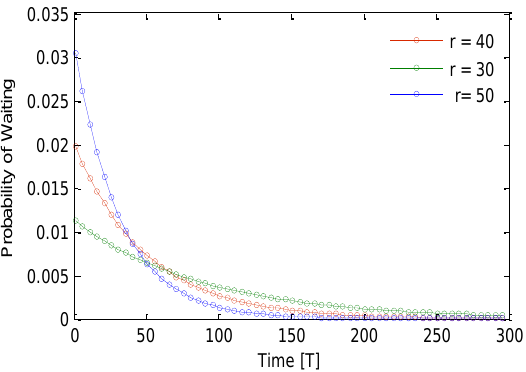
Figure 8. Probability of waiting for a finite time for the HelloReq packet.